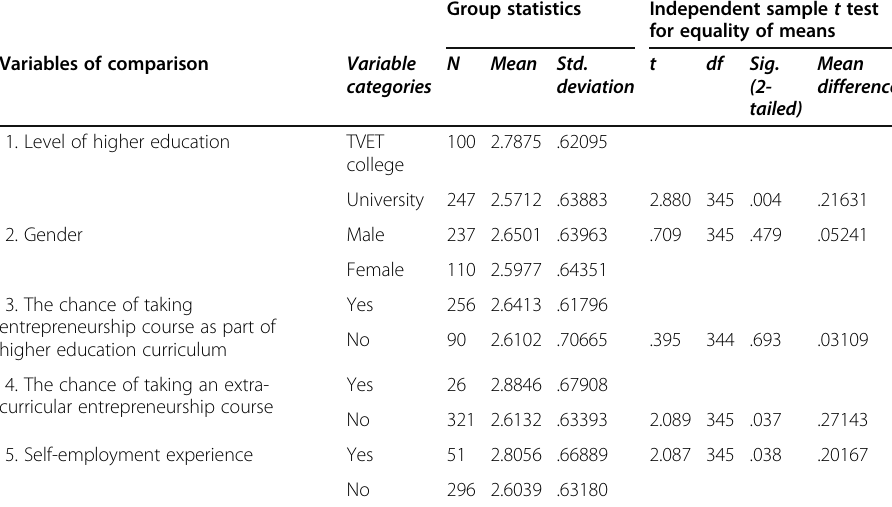
Table 2 Summary description of independent sample t test